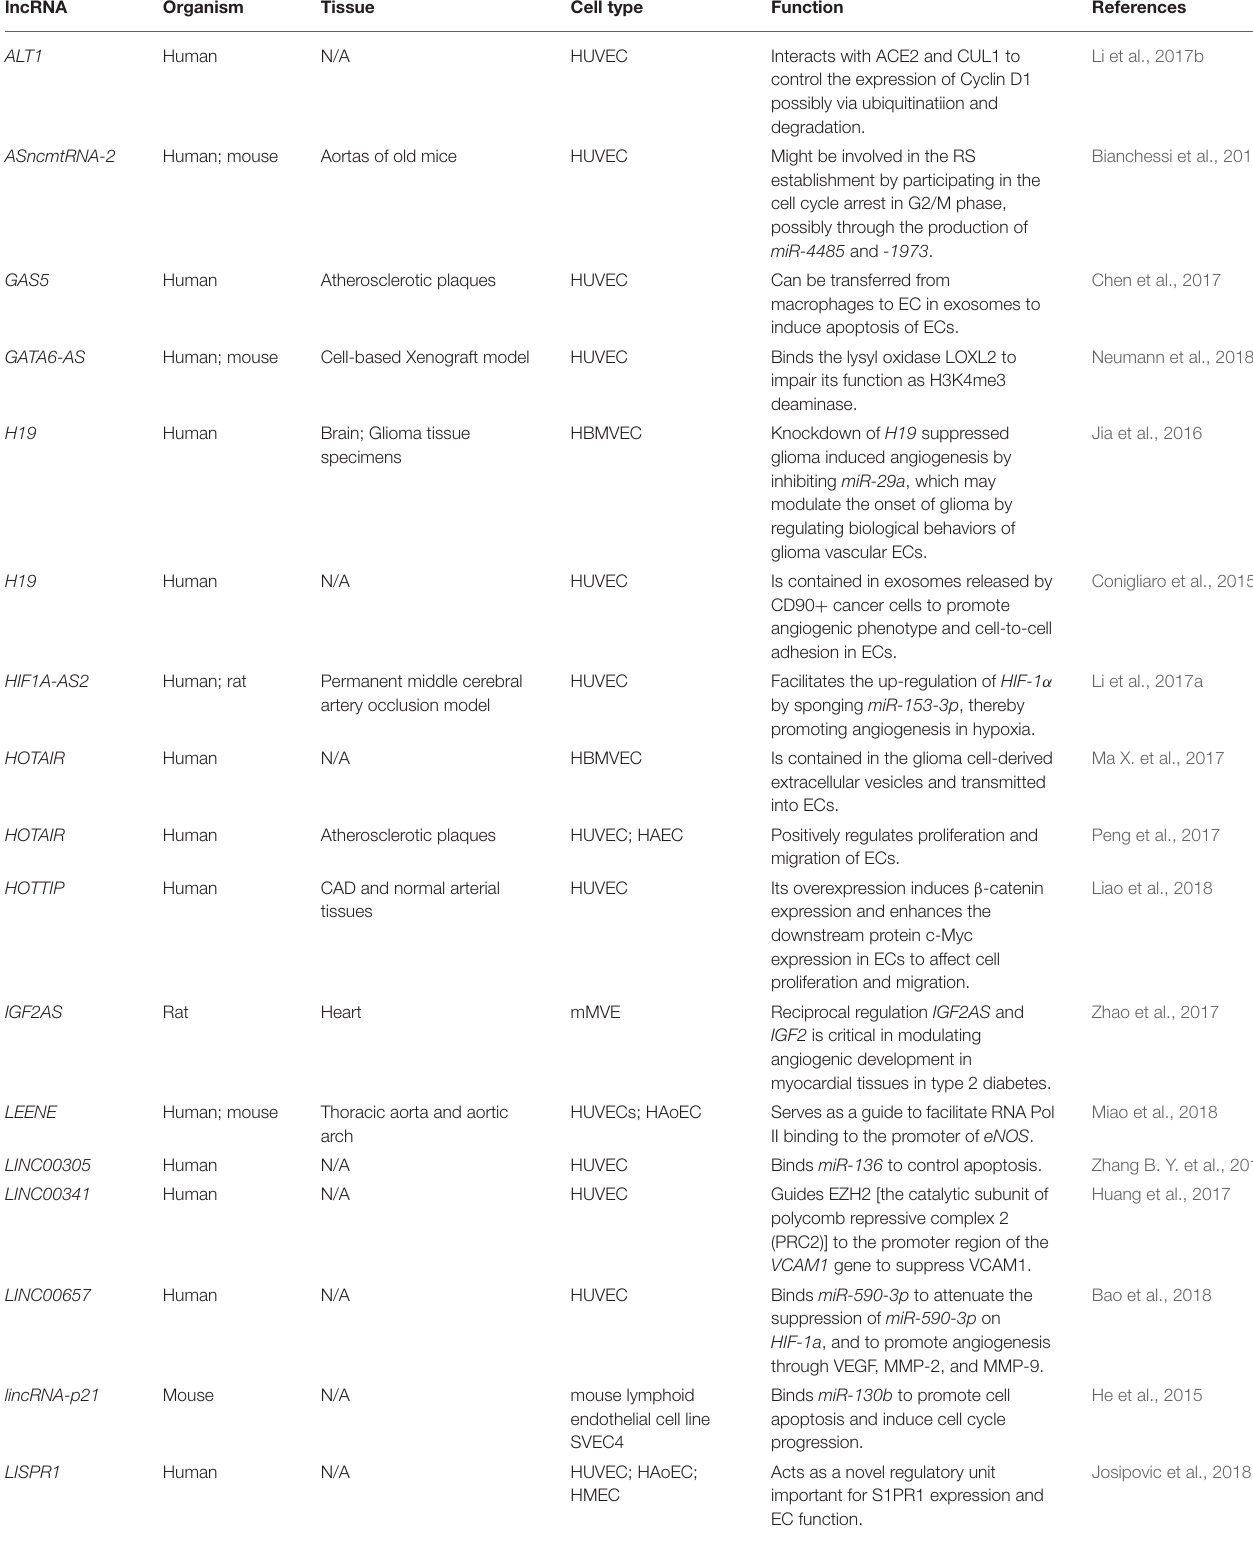
TABLE 1 | List of lncRNAs in endothelial